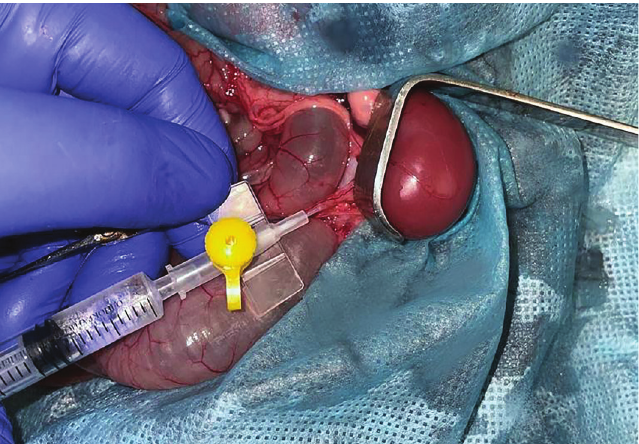
Figure 2 - Introduction of bacterial suspension into the